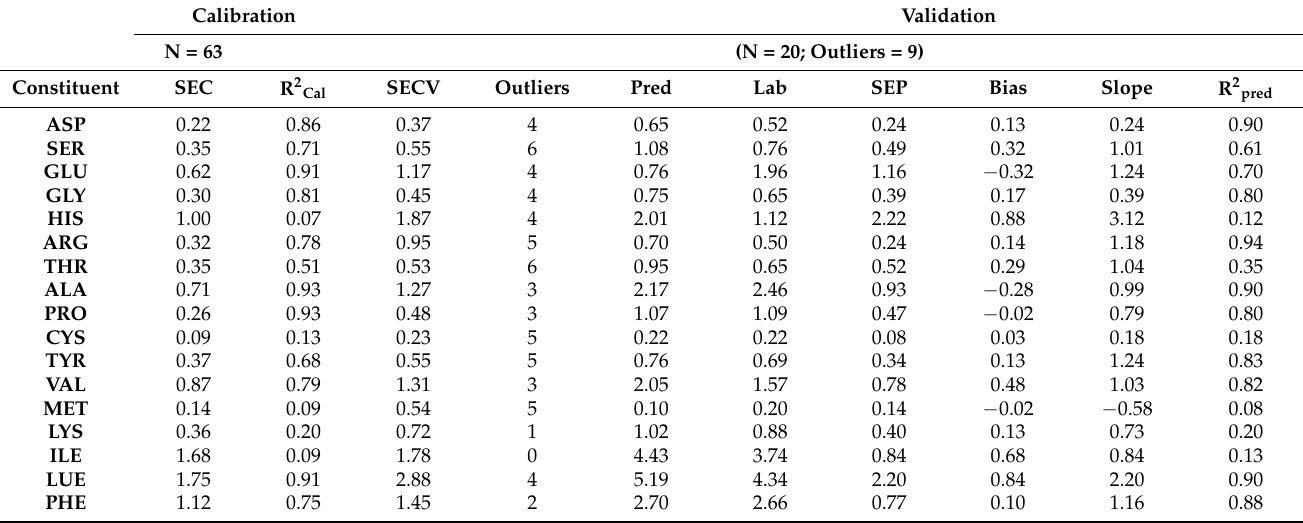
Table 2. Calibration and validation statistics of prediction models developed for amino acids. Pre- processing and mathematical treatments (SNVD, +